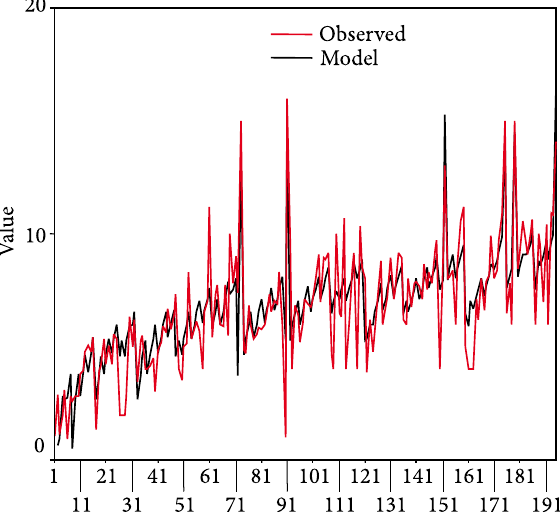
Fig. 2. A comparison of model results with observations The data indicates that the obtained results of the model have a good concordance with the results of the observations; hence, the calibrated model has the re- quired precision.